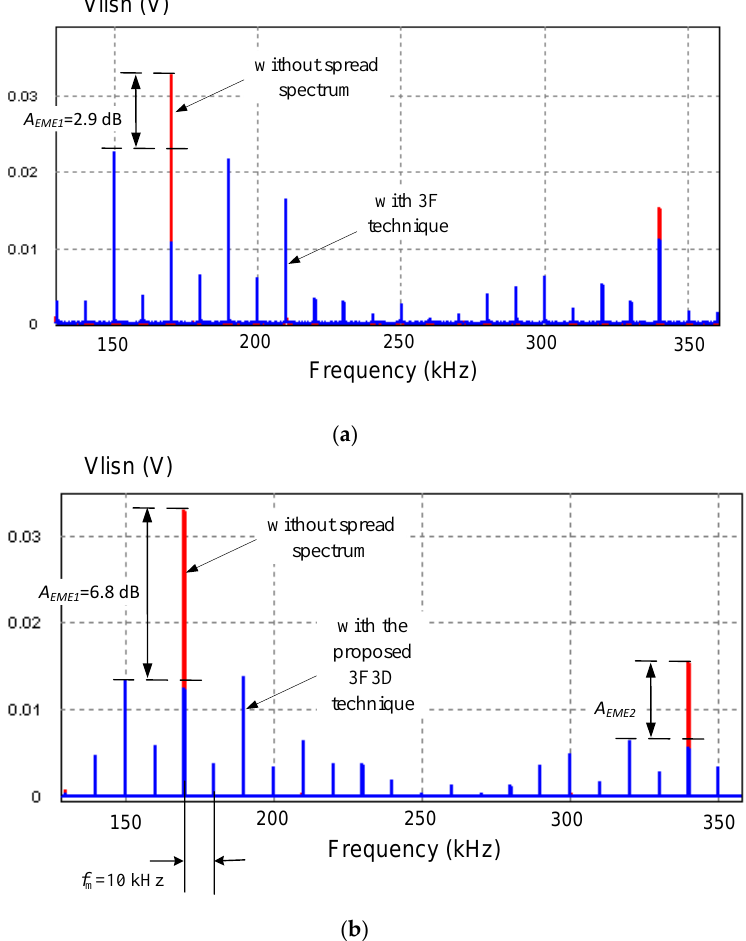
Figure 5. Simulated conducted EME (LISN output voltage) spectra: ( a ) when the spread spectrum is not used and when the conventional 3F (three-frequency) technique is used; ( b ) when the spread spectrum is not used and when the proposed 3F3D technique is used. Note: switching frequencies are 150, 170 and 190 kHz; for 3F3D technique D 1 = 20%; D 2 = 50%; and D 3 = 22%.